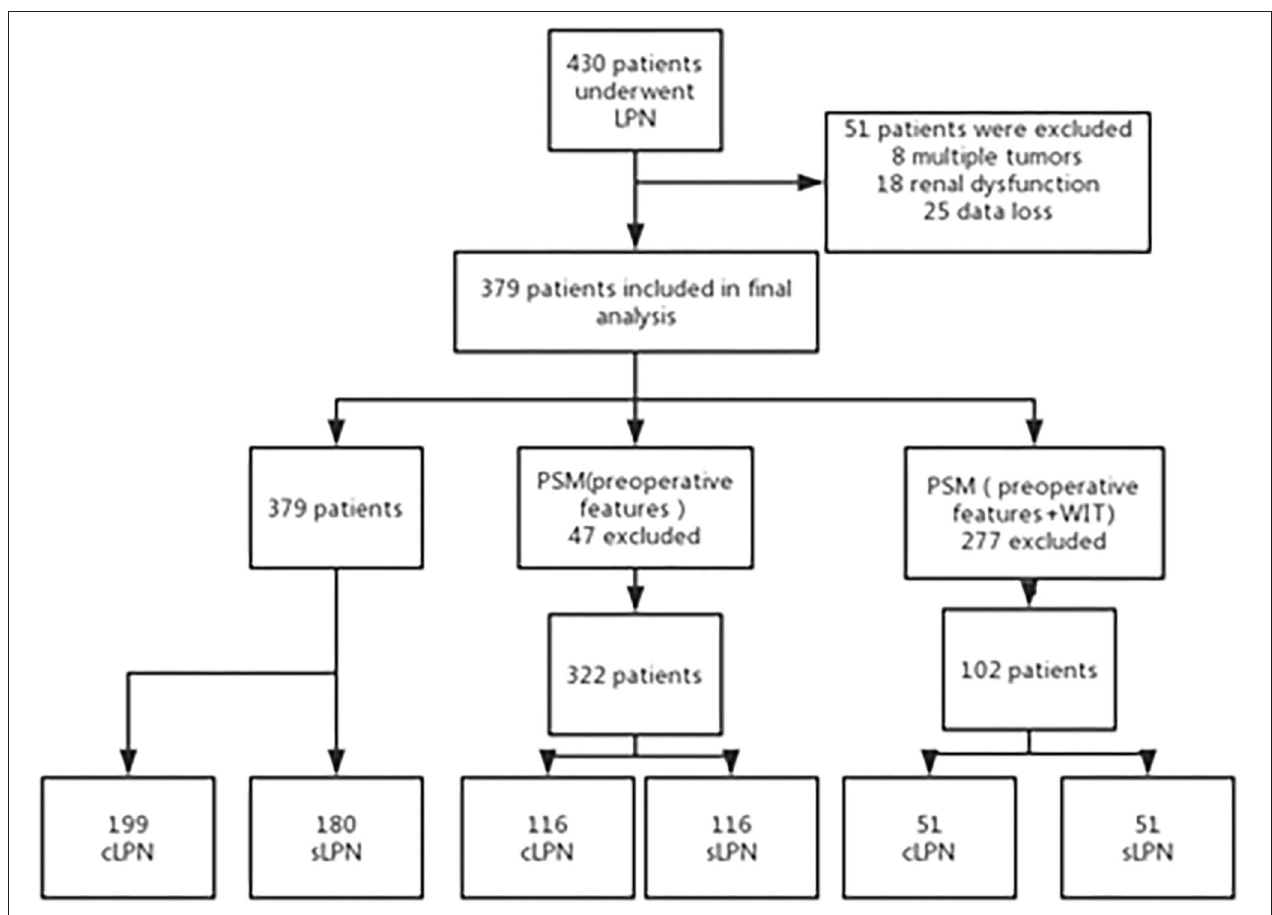
FIGURE 1 | Flow chart of the study.